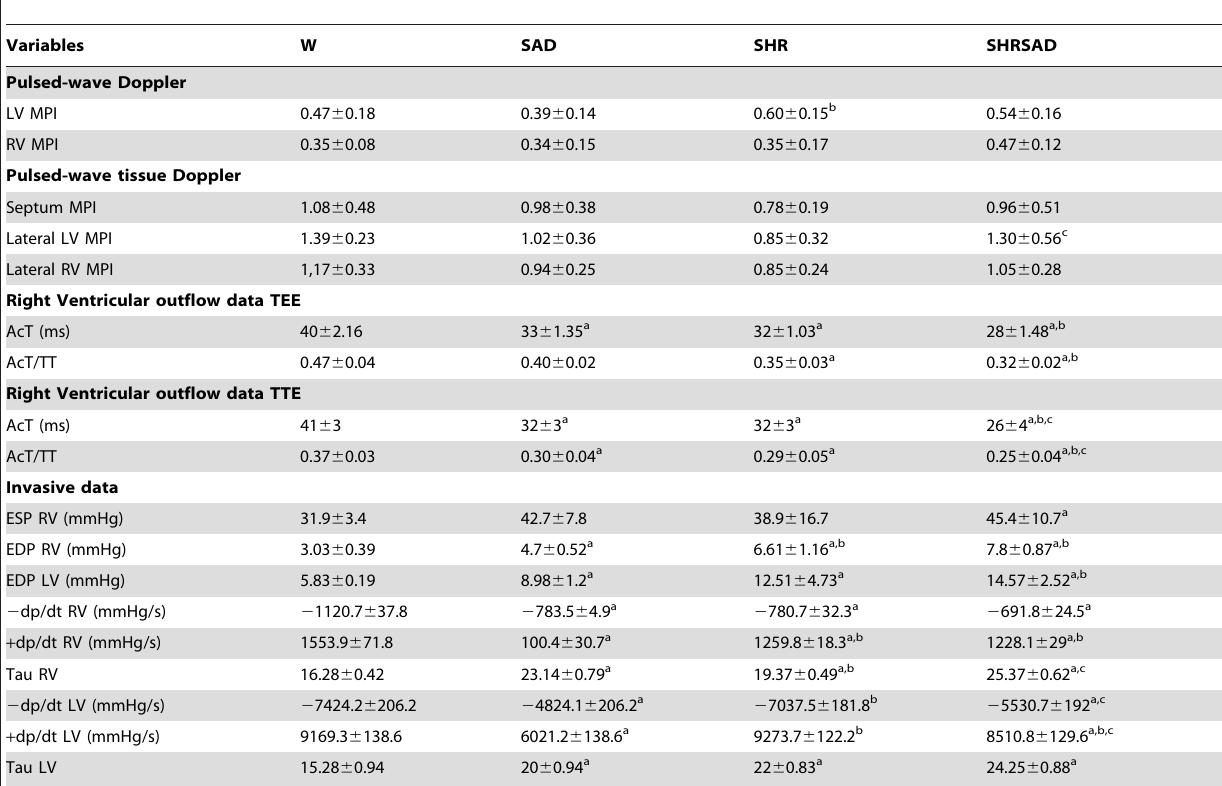
Table 4. Myocardial performance index, right ventricular outflow by transesophageal, transthoracic echocardiography and invasive